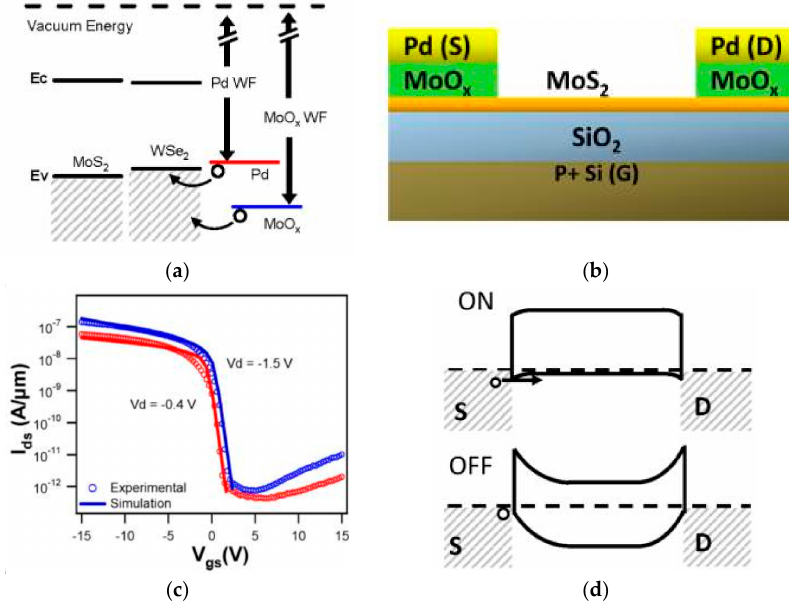
Figure 3. MoS 2 /MoO x heterojunction. ( a ) Valence and conduction band positions with respect to vacuum level for MoS 2 , WSe 2 , Pd, and MoO x ; ( b ) Schematic of the device structure; ( c ) I ds vs. V gs characteristics for a representative MoS 2 PFET with MoO x contacts; ( d ) Qualitative band diagrams for the ON (top panel) and OFF (bottom panel) states of the MoS 2 PFET (Steven Chuang et al. [49]).